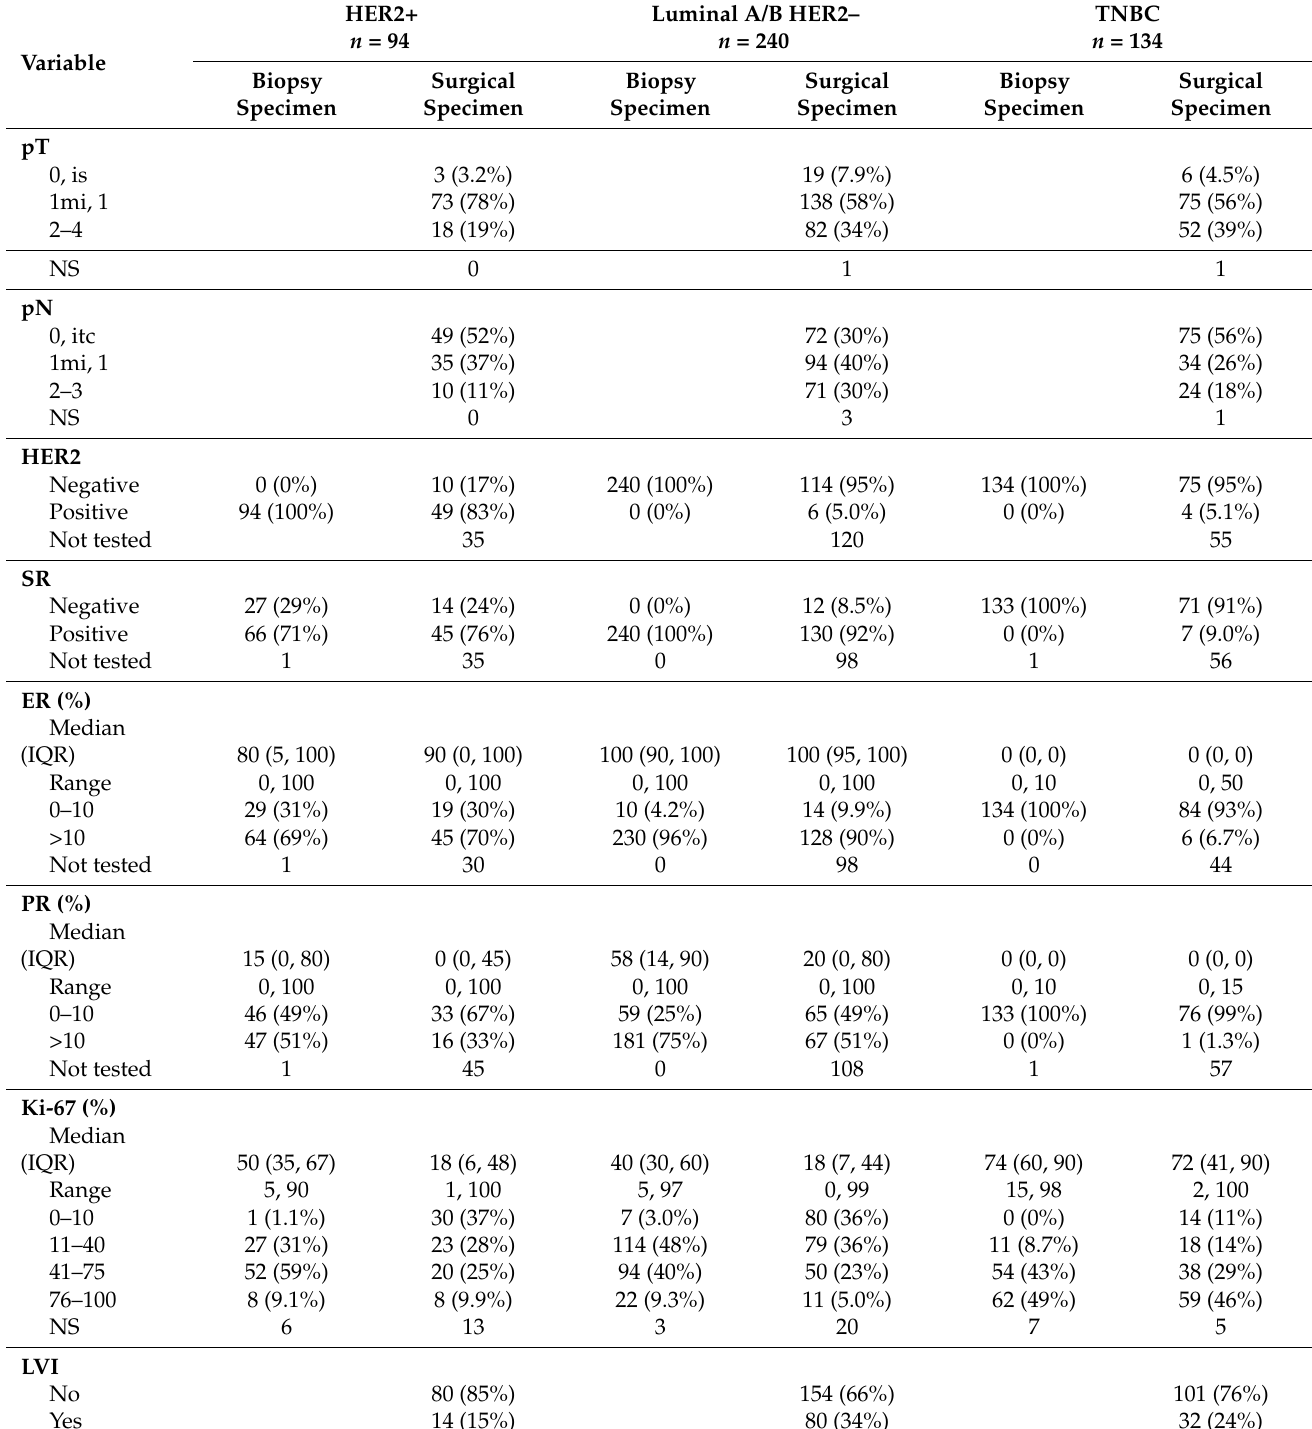
Table 2. Pathological pre- and post-NAT